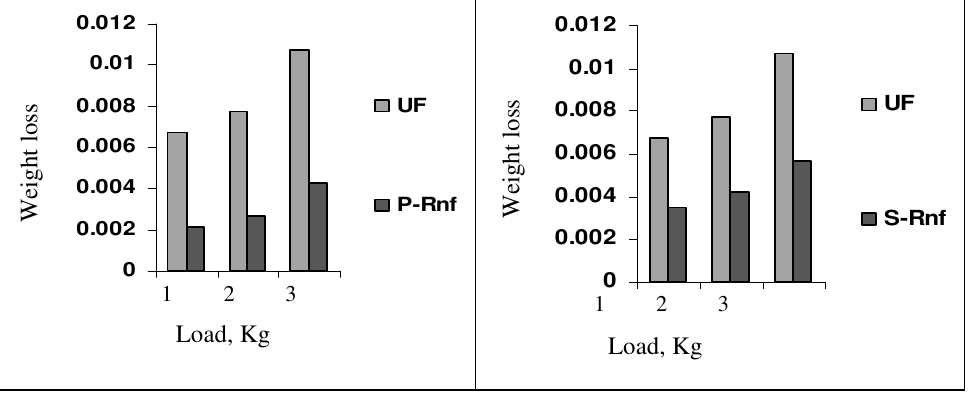
Figure 12. Wear resistance of P-Rnf composite